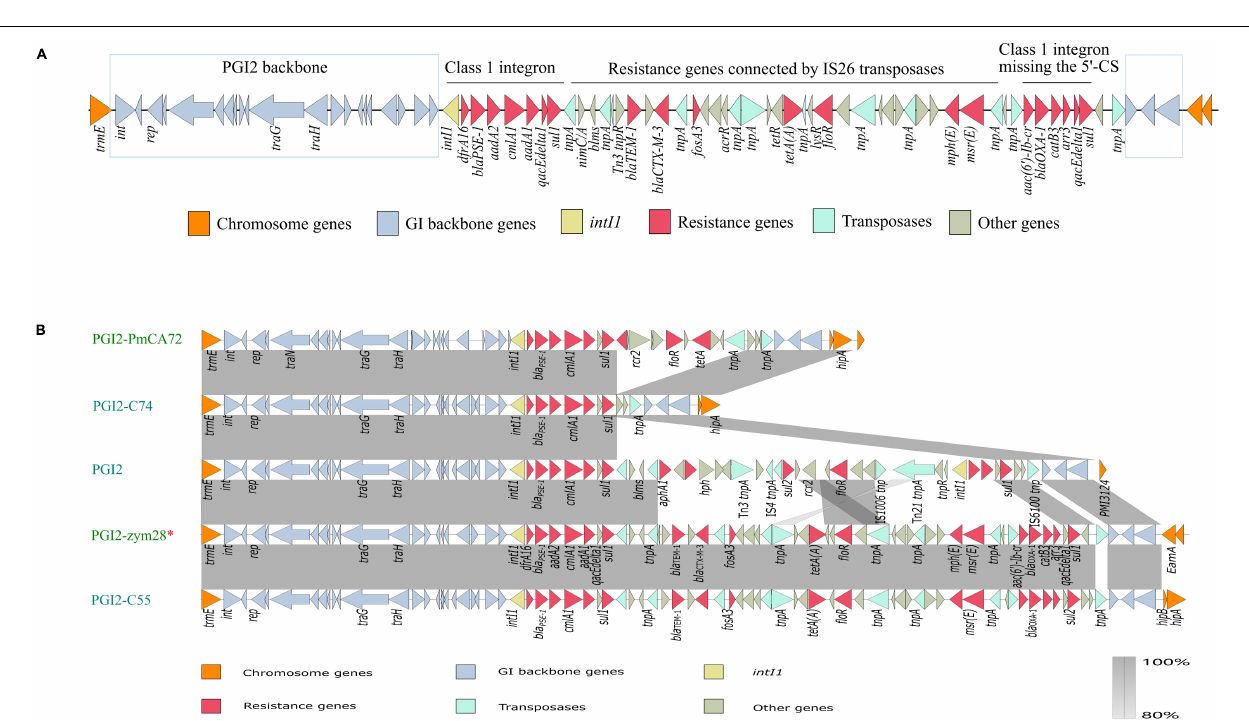
FIGURE 1 | Phylogenomic and population structure analysis of Morganella morganii genomes worldwide combined with the distribution of resistance genes among Morganella morganii. Isolates identifiers are omitted. Branch in blue shows phylogenomic clade 1. Pie chart beside the blue branch represents the geographical origins of clade 1 isolates. BAPS sequence clusters are indicated by filled colored rectangles. Strain zy-m28 and nx_m63 in this study are noted with orange hollow rectangles.